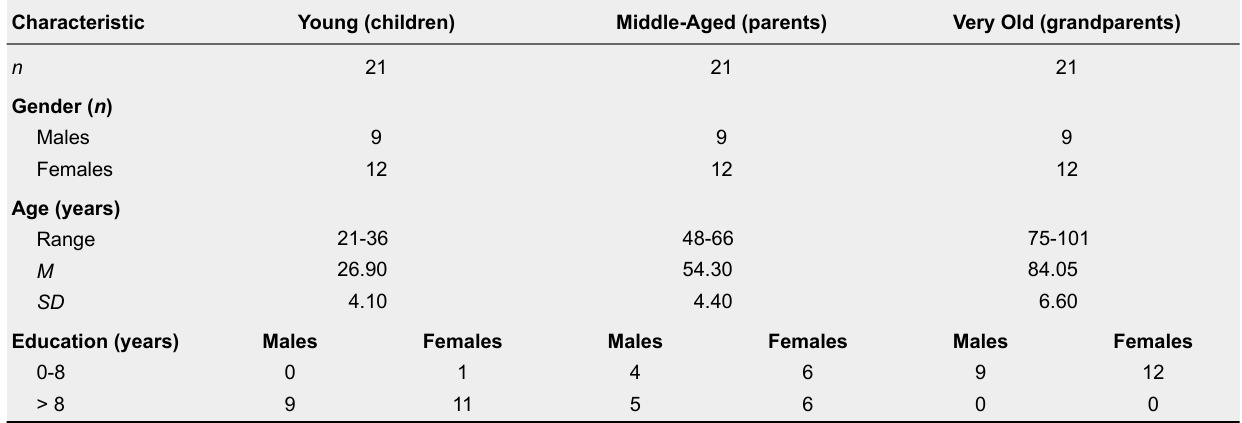
Socio-Demographic Characteristics of the